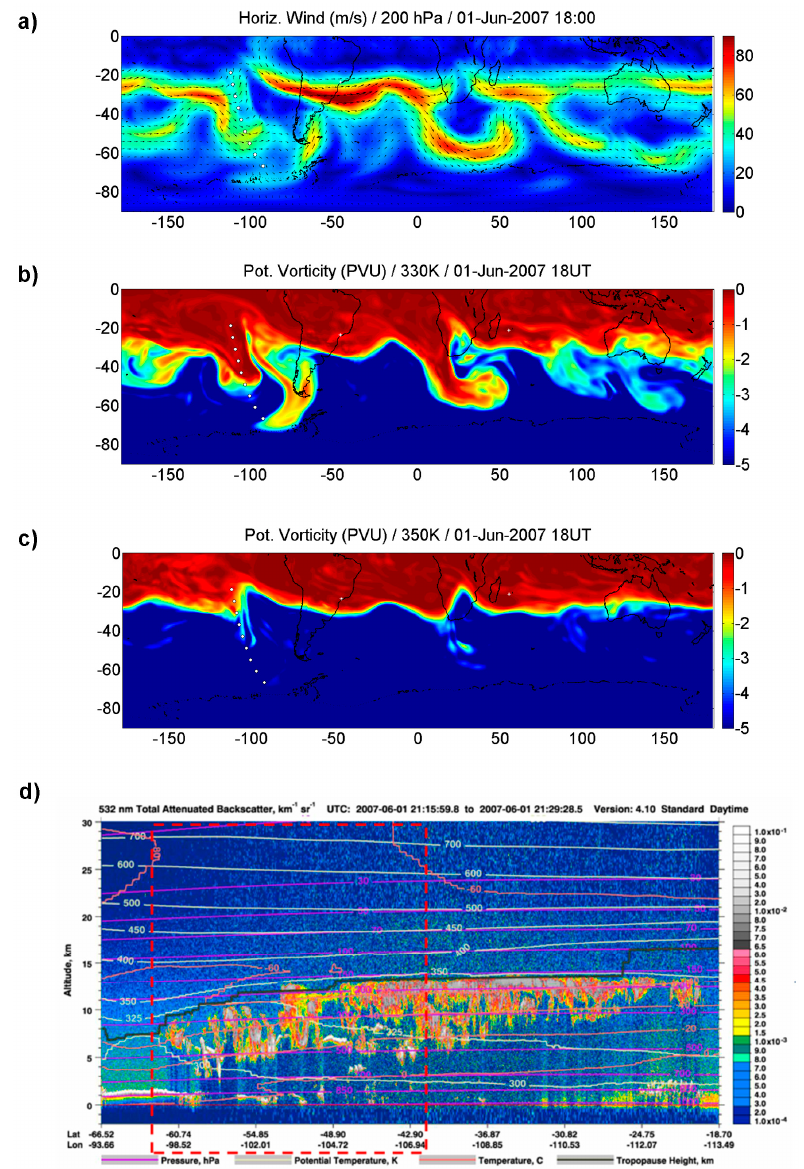
Figure 6. ( a ) Wind map at 200 hPa for 1 June 2007 by ECMWF-ERA-Interim reanalysis. Arrows indicate the direction, while colors indicate the wind intensity in m s − 1 . ( b ) Advected potential vorticity (PV) field at 330 K by LACYTRAJ at 18 UTC on 1 June 2007. ( c ) Advected PV field at 350 K by LACYTRAJ at 18 UTC on 1 June 2007. ( d ) CALIPSO cloud detection, 21:15 to 21:29 UTC on 1 June 2007. The white dot lines in ( b ) and ( c ) indicate the CALIPSO tracking shown in ( d ). The white stars in ( b ) and ( c ) indicate the cirrus cloud detection by MSP and Maïdo